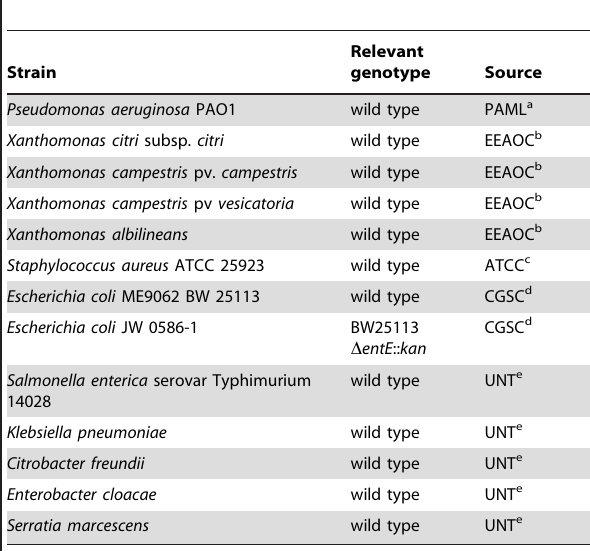
Table 5. List of strains used in this